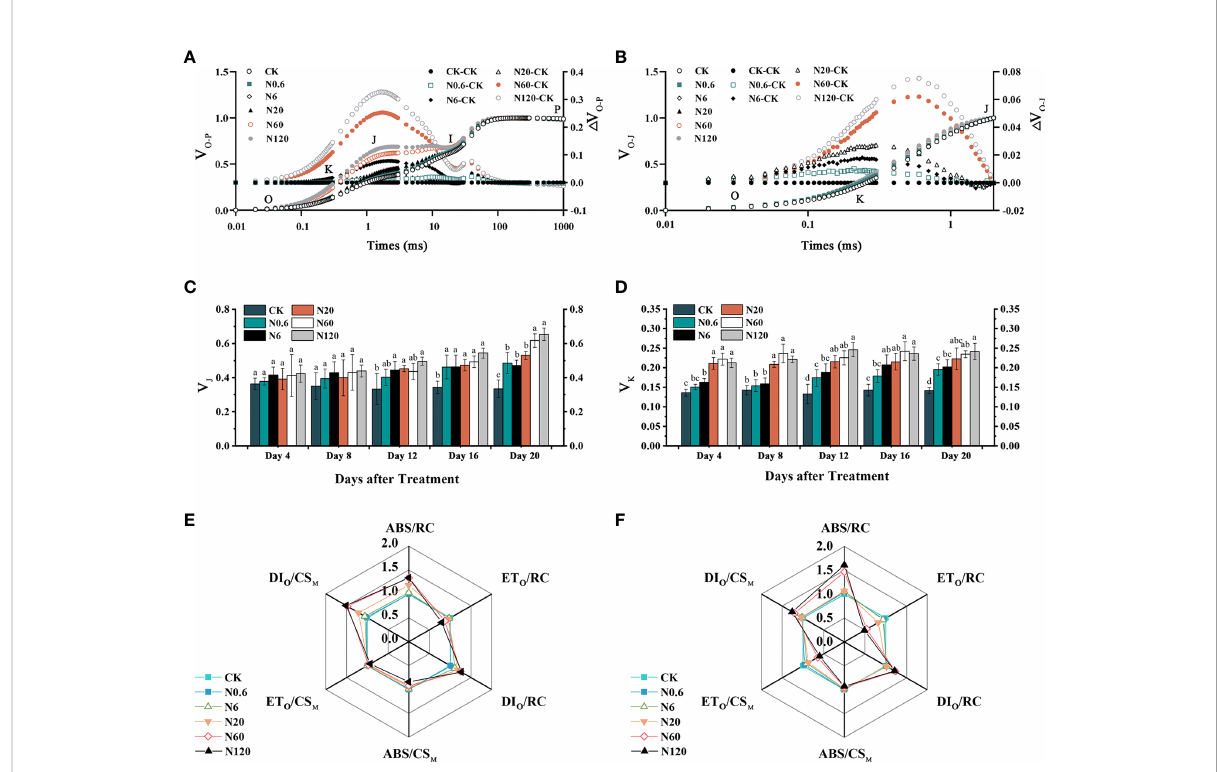
FIGURE 6 Effects of nicosulfuron on the photosynthetic energy of sugar beet leaf. V O-P , D V O-P curves on 20 DAT (A) , V O-J , D V O-J curves on 20 DAT (B) , V J (C) , V K (D) , energy distribution parameters on 4 DAT (E) and 20 DAT (F) in sugar beet leaf after treatment with different doses of nicosulfuron. Data with the different letters indicate signi fi cant differences between different doses of nicosulfuron drift (n = 6, p <